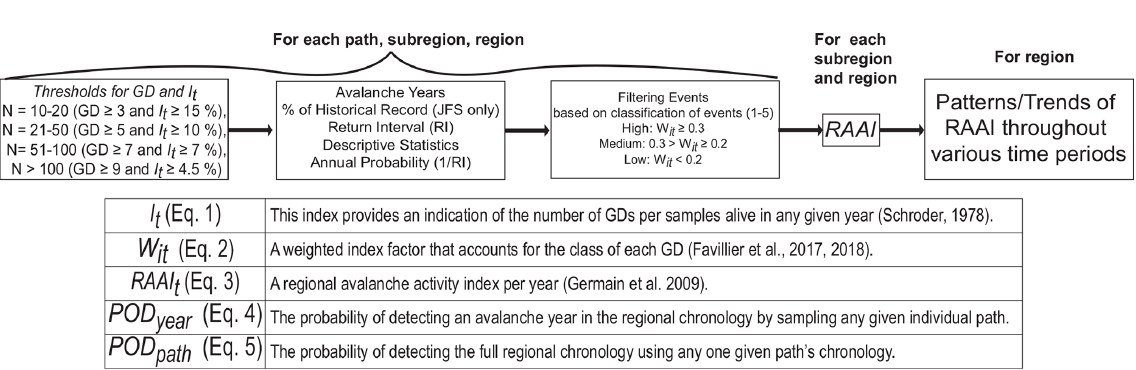
Figure 2. General workflow of analytical methods to reconstruct regional avalanche chronology, regional avalanche activity index, and the probability of detection. N is sample size. GD is growth disturbances. I t is index of ratio of responses to trees alive. RI is return interval. W it is weighted index as per Favillier (2017, 2018). RAAI is regional avalanche activity index as per Germain et al. (2009). POD is probability of detection. See Eqs. (1)–(5) for